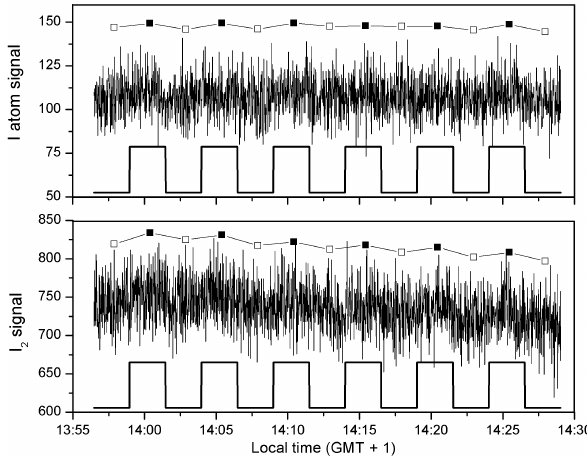
Fig. 9. Example of raw field data. Top panel: I atoms ( ∼ 6pptv); bottom panel: I 2 ( ∼ 150pptv). The squared pulse function indicates the 3-way valve state, i.e. the sampling mode (low: background, high: direct). The time basis is 1s, whereas the time resolution defined by the 3-way valve state is 300s (150s background+150s direct sampling). Squares represent the averaged signal in the cor- responding interval, shifted upwards by an arbitrary constant for clarity. Empty squares refer to background measurements. The size of the squares indicates the standard error of the